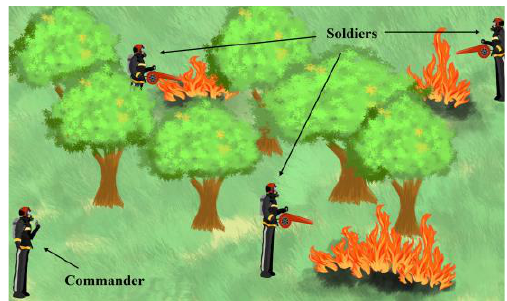
Figure 1. CL in the building environment.